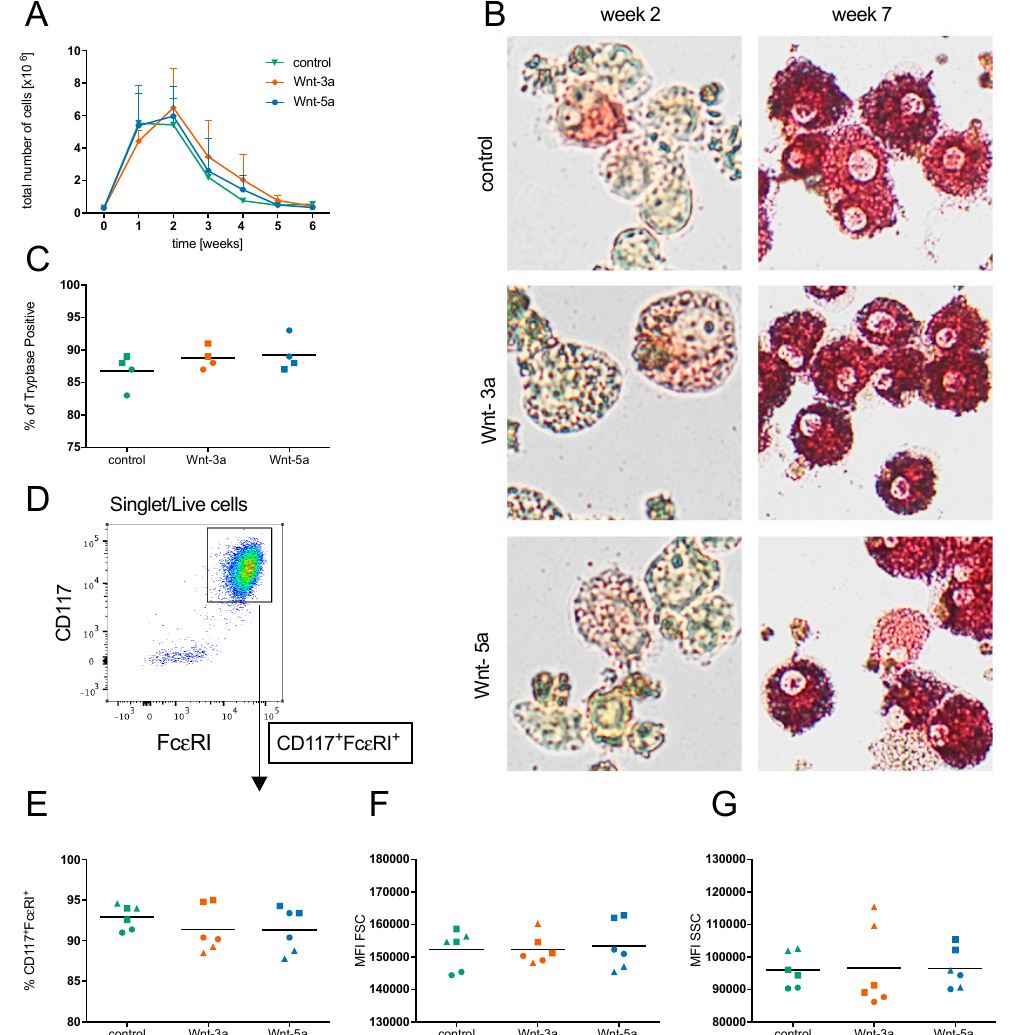
Figure 3. Stimulation with purified recombinant WNT does not influence mast cell maturation. CD34 + cells enriched from buffy coats were cultured for seven weeks under conditions that promote mast cell development, with weekly addition of 100 ng/mL Wnt-3a or Wnt-5a. The total number of cells during the culture period was quantified as the means with SEMs ( A ). The cells were stained for tryptase activity at week 2 and week 7 ( B ), and the percentages of tryptase-positive cells at week 7 were quantified ( C ). The cells were analyzed by flow cytometry; representative gating of developed mast cells at week 7 is shown in ( D ), and quantification of the gated CD117 high Fc ε RI high mast cells is shown in ( E ). Mean fluorescence intensity (MFI) of the FSC ( F ) and SSC ( G ) of the gated mast cells. Cells from three individual donors were analyzed in duplicate ( n = 3), and each symbol represents an individual